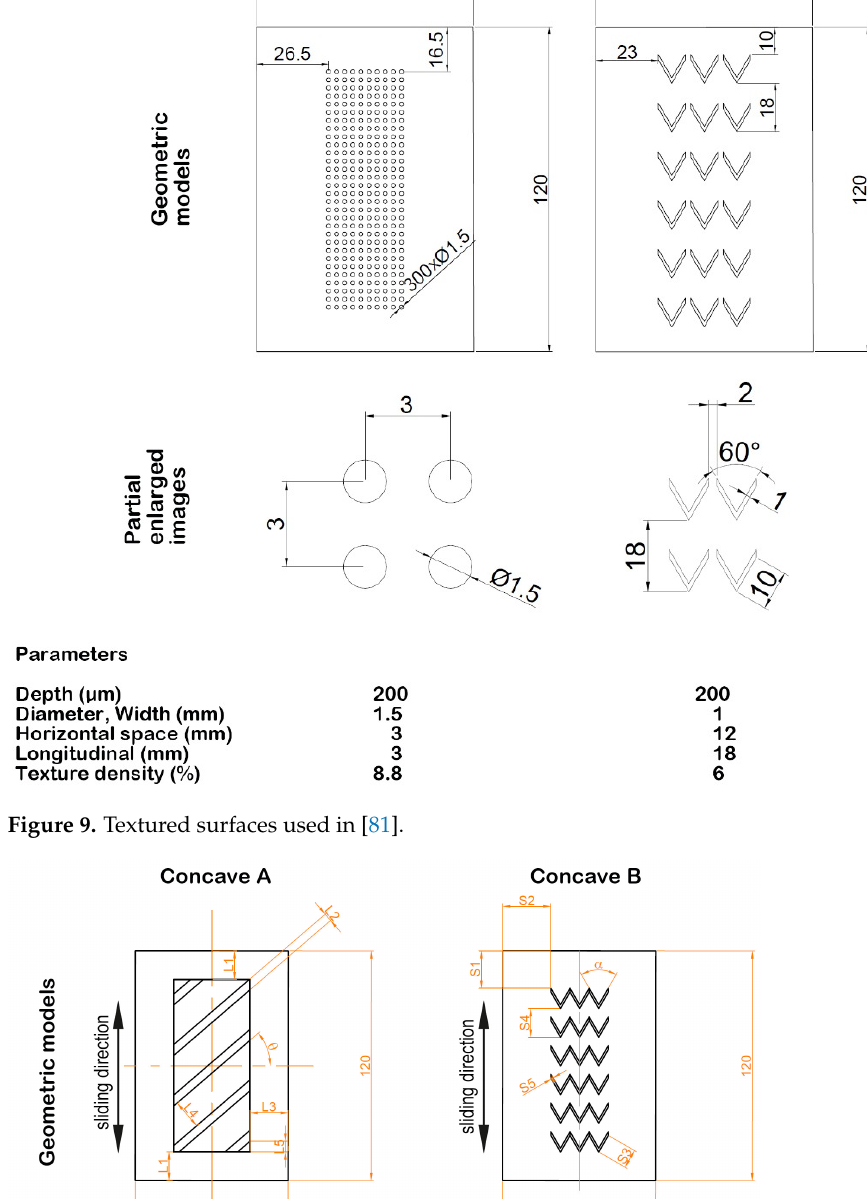
Figure 10. Cylinder samples tested in